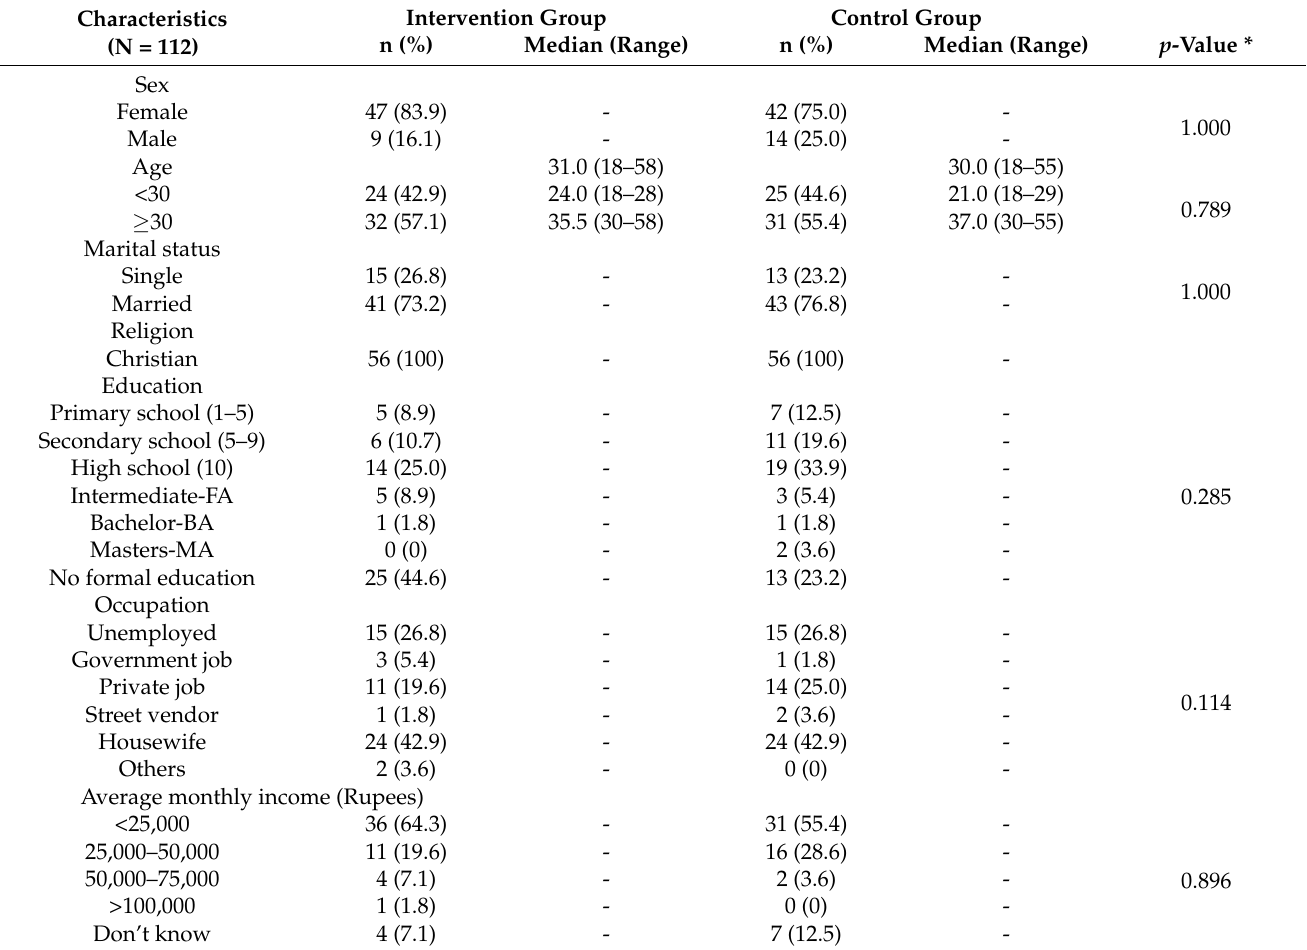
Table 2. Sociodemographic characteristics of the intervention and control groups surveyed